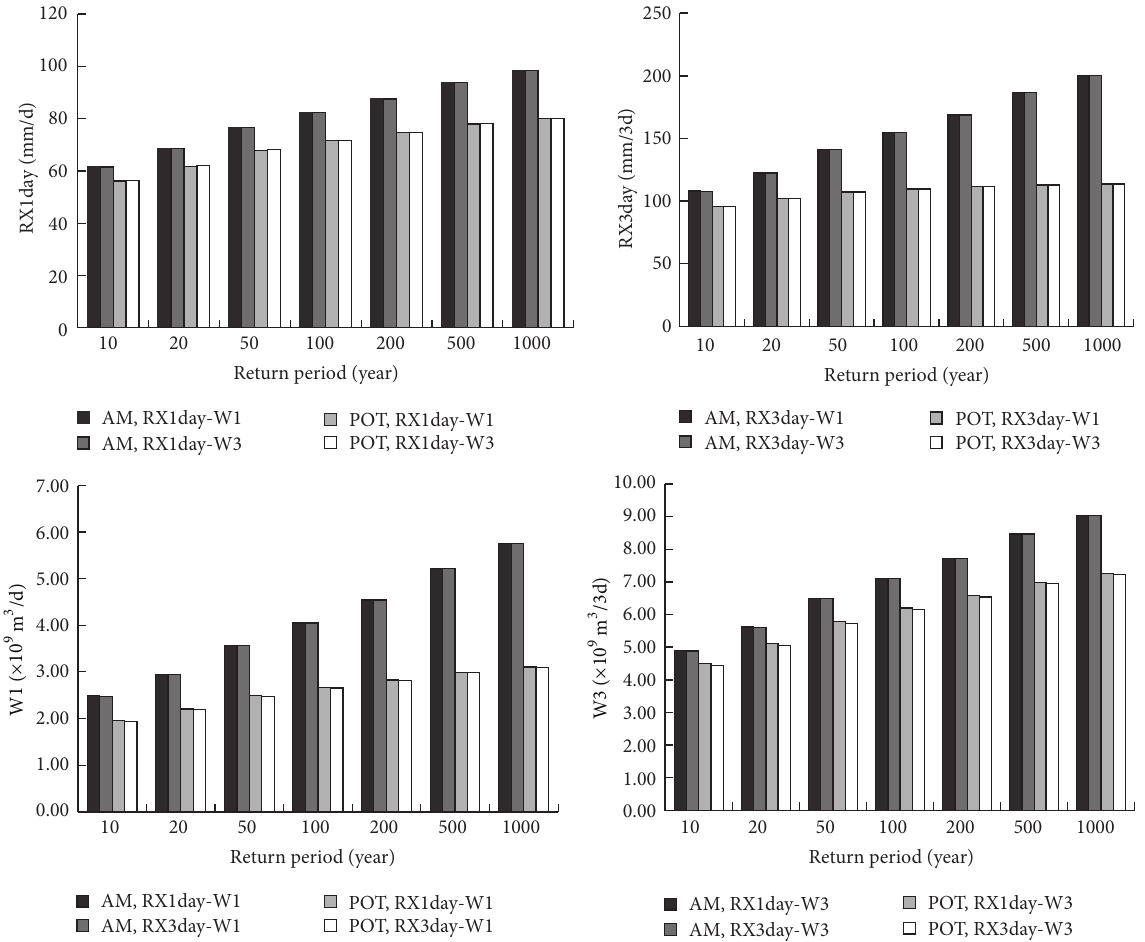
Figure 4: Extreme precipitation and flood discharge estimated via 2D joint distributions under a range of return